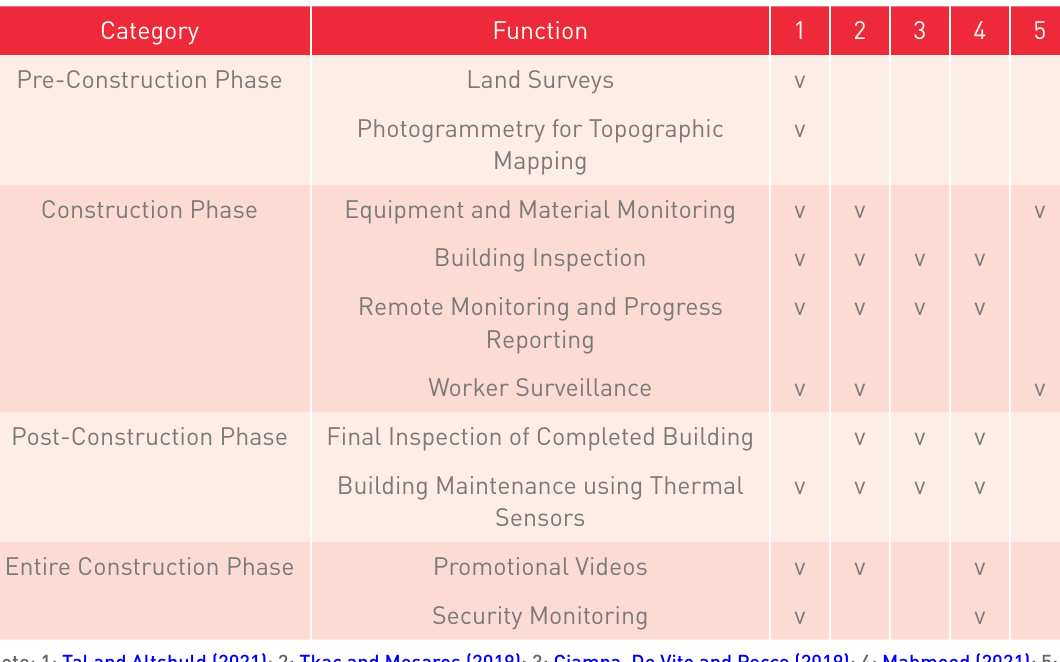
Drone functions in